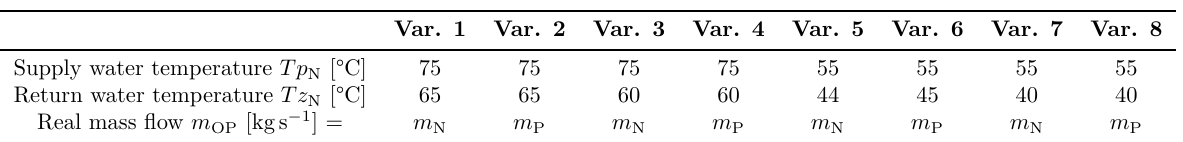
Table 1. Boundary conditions to calculate the internal temperature of the room ( m power output, m P = mass flow for room heat loss).